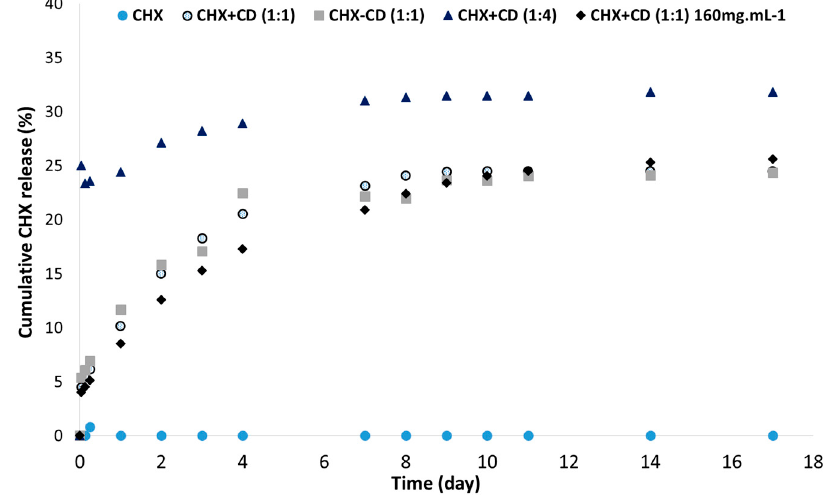
Figure 2. Cumulative CHX release (%) through time according to the complexation of CHX with CD and polymers ′ concentrations, as measured by UV spectrometry. The formulation used was PLGA:PLC (60/40) with CHX (4%). CHX + CD means CHX and CD were added together during the polymers ′ solubilization. The lyophilized CHX-CD complex powder was added during the polymers ′ solubilization.